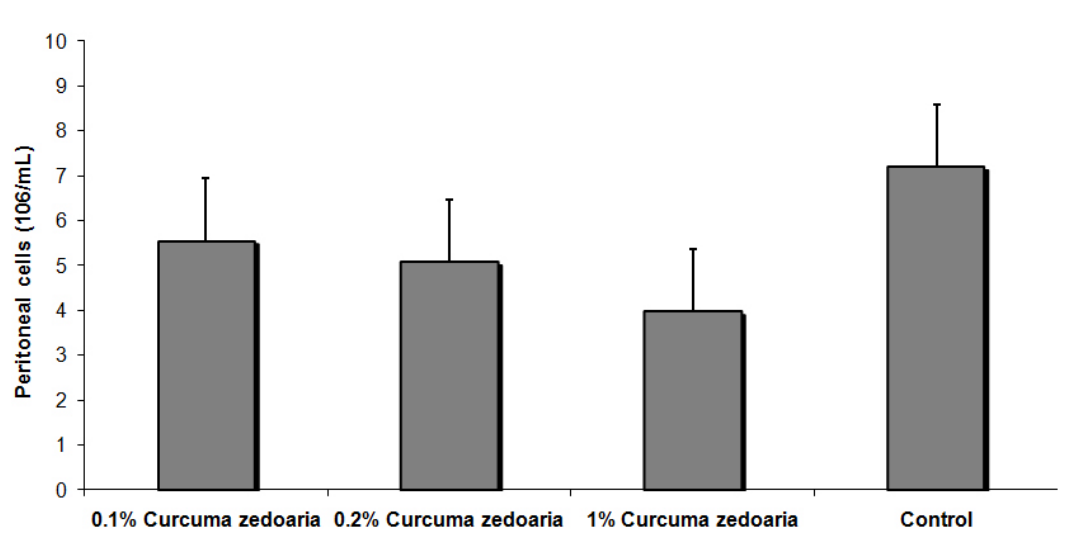
Figure 4. Cell migration to the peritoneal cavity. C57BL/6J mice were treated with 0.1, 0.2 and 1% Curcuma zedoaria crude extract. Data are expressed as mean ± SD.